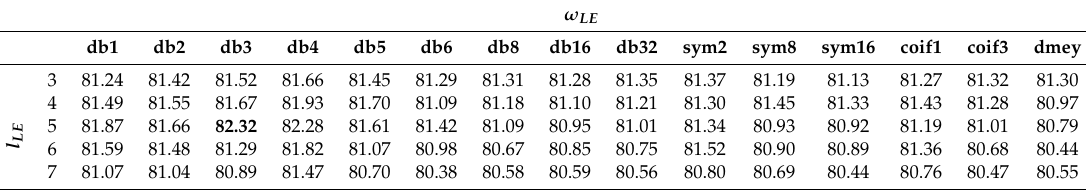
Table 18. The accuracy (%) of five class sleep stage classification with different ω LE and l LE under R&K standard.